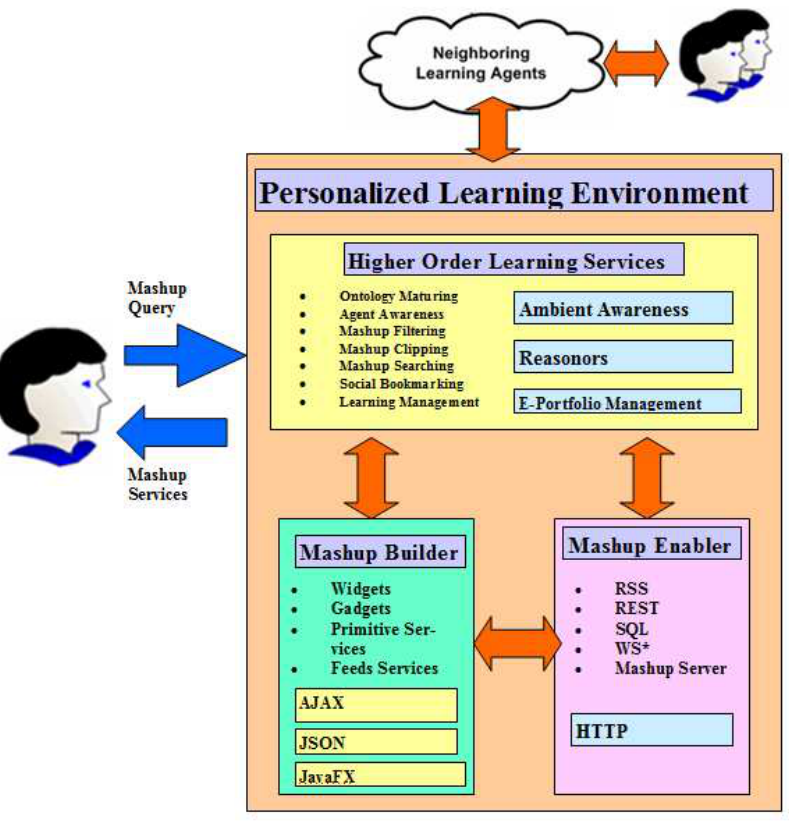
Figure 8: A framework for Mashup Personalized